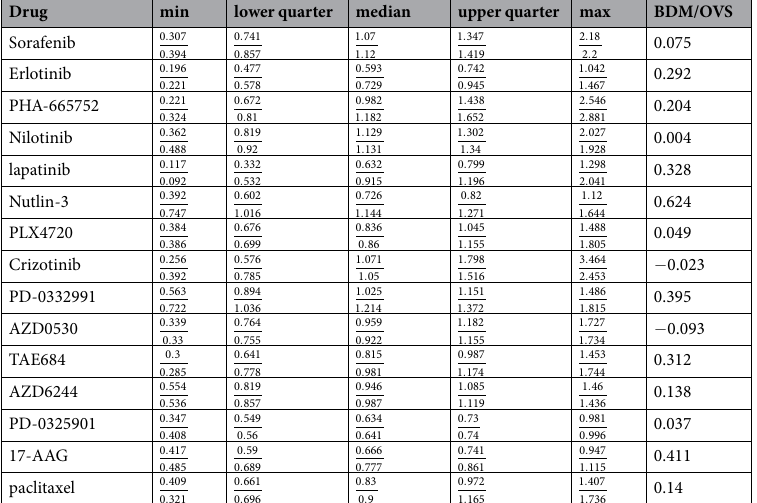
Table 1. Statistical metrics to compare test error rates from shared GDSC model (numerator) and CCLE alone model (denominator) in scenario 2 when portion of GDSC dataset was withheld as test